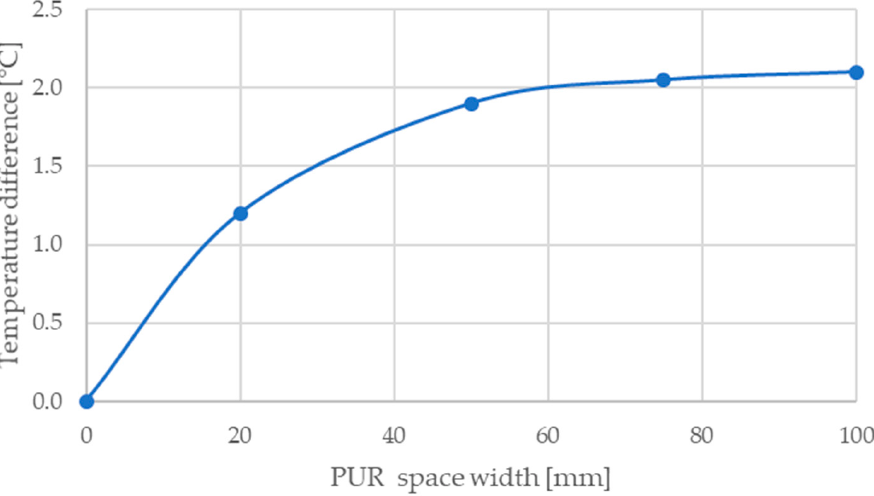
Figure 9. Dependence of the surface temperature drop on the inner surface of the panel with 10 mm VIP on the width of the gap filled with PUR foam.